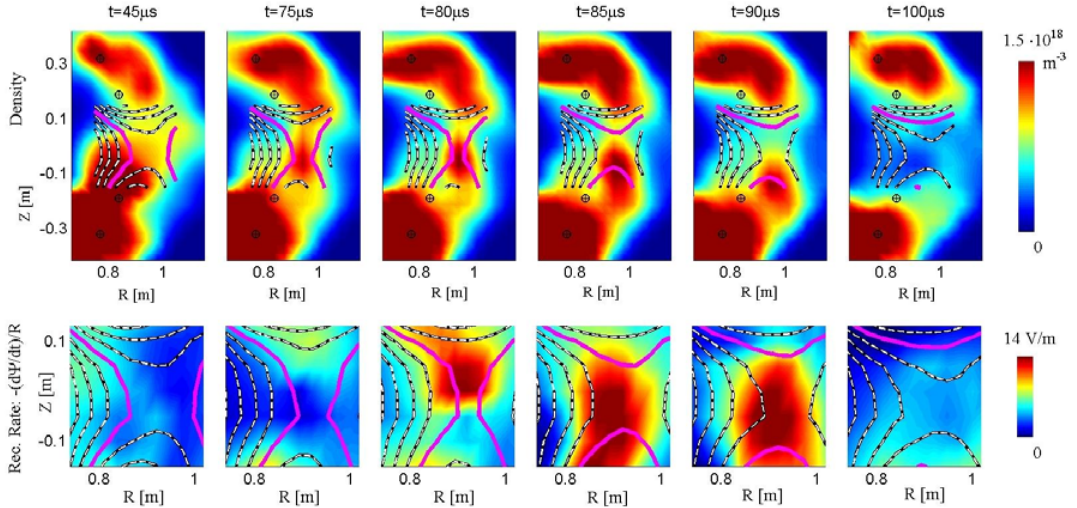
Figure 3. A laboratory spontaneous magnetic reconnection event in the Massachusetts Institute of Technology VTF [28], depicted by measured contours of the plasma density, floating potential, current density, and the reconnection rate. The overlaid lines represent contours that coincide with the potential projection of magnetic field lines; see also Section 4.4,